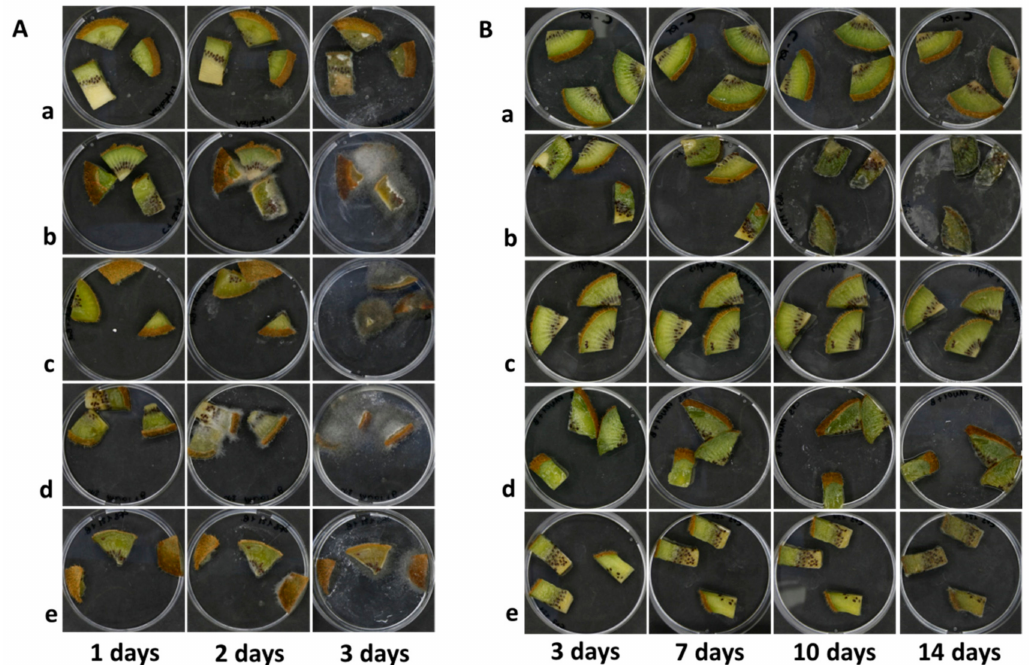
Figure 3. Image acquisition of kiwifruit pieces non- ( a ) or artificially contaminated with B. cinerea CECT 20973 ( b ) and treated with Fenhexamid ( c ), CFS48 of L. plantarum PAN01 ( d ), or UFG 121 ( e ), and stored for 3 days at 25 ◦ C ( A ) or for two weeks at 4 ◦ C ( B